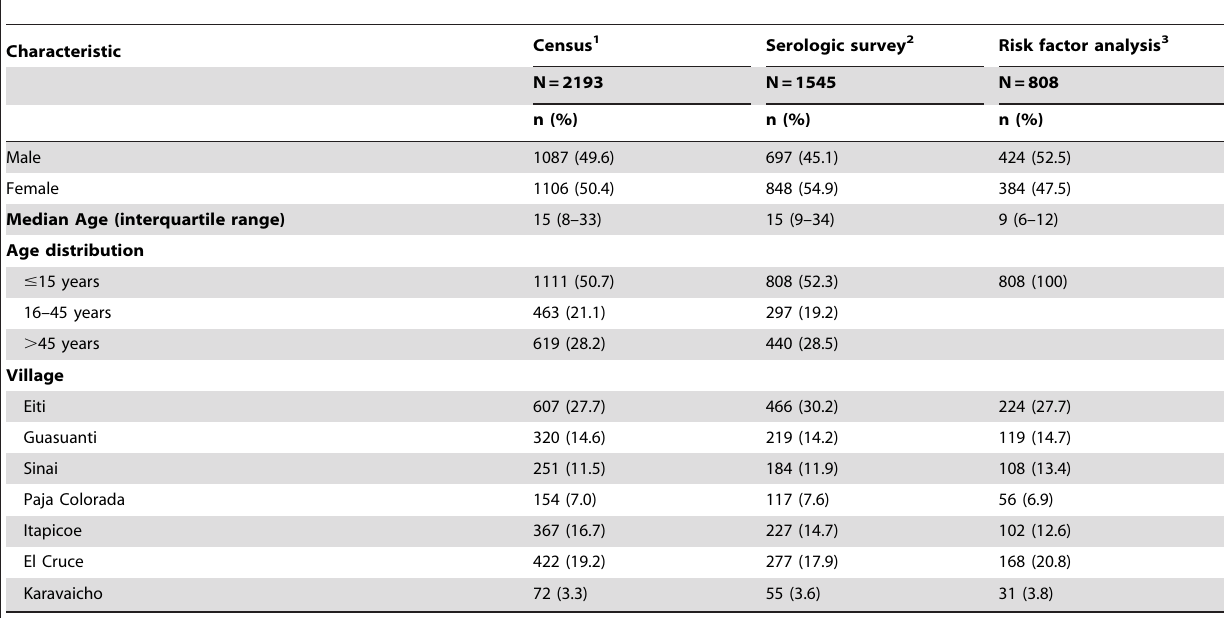
Table 1. Demographic characteristics of participants in the census, T. cruzi serosurvey and the risk factor analysis.